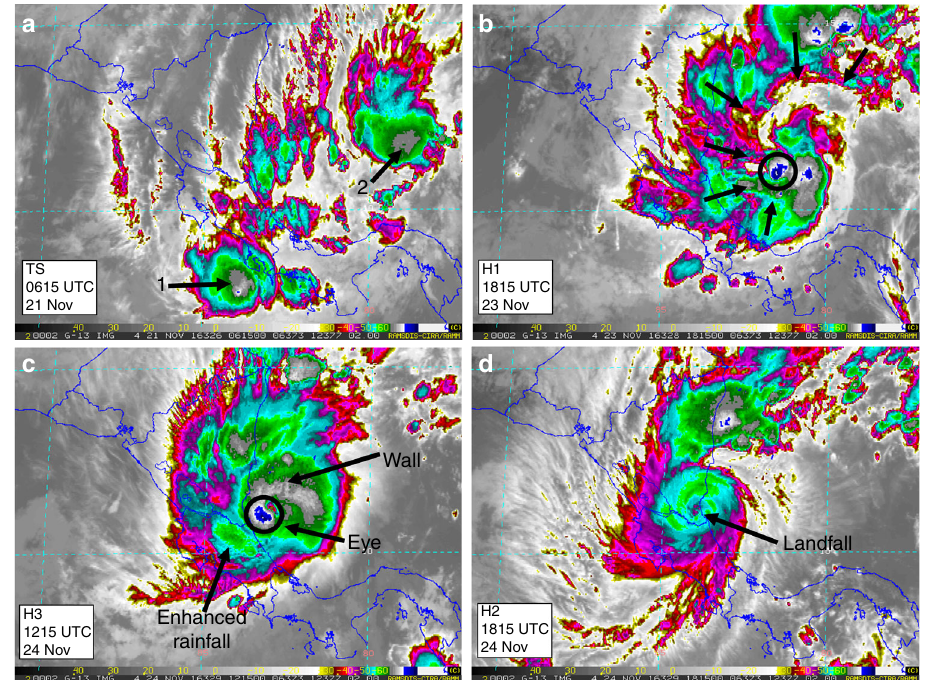
Fig. 2 Satellite evolution of Hurricane Otto. GOES-8 (Geostationary Operational Environmental Satellite) East Thermal IR brightness temperature (IRTB) imagery retrieved from the RAMSDIS (Regional Advanced Meteorological Satellite Demonstration and Interpretation System) website during the event (http://rammb.cira.colostate.edu/ramsdis/online/). The evolution of Hurricane Otto is shown as the organization of convection going from a TD (Tropical Depression) to TS (Tropical Storm) ( a ) (two convective nuclei are noted by numbers 1 and 2). Well-de fi ned convective clouds (shielded by the green IRTB contours) organized around the low pressure minimum ( b ) displaying a cyclonic motion as the system intensi fi ed to a H1 (black arrows denote dragged moisture transport). Favorable conditions, including warm water (SST > 29 °C) allowed the increase to H3 with a well-de fi ned and nearly steady eye and wall ( c ). Green contours over northeastern Costa Rica show evidence of convective rainfall as Otto approached land (1605 UTC November 24, 2016) ( d ). Despite the rapid decline of the hurricane, its pass across the Costa Rica-Nicaragua border was followed by high convective rainfall